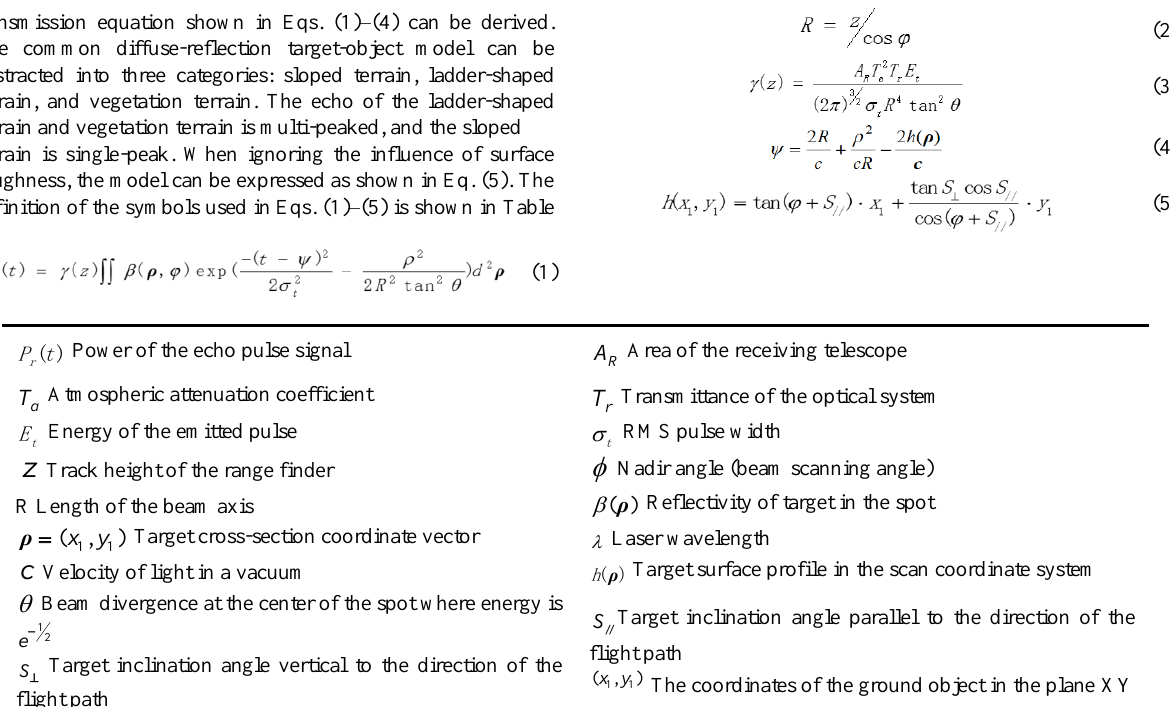
Table 1. Definition of the symbols used in Eqs. (1)–(5).